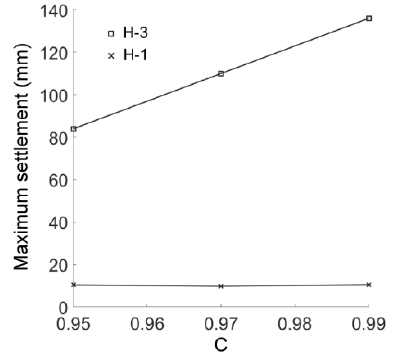
Figure 27. Maximum settlement of measuring lines H-1 and H-3 as a function of Convexity.